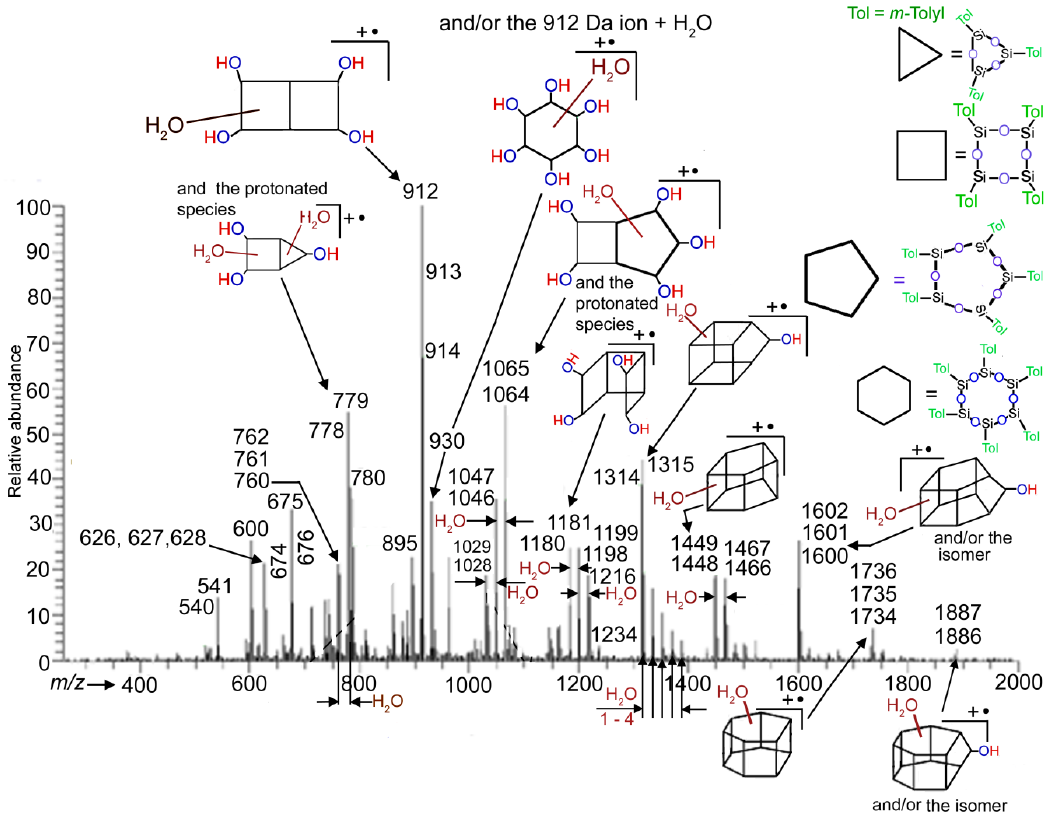
Figure 5. PI APCI mass spectrum of a mixture of m -tolylcyclosiloxane products from the hydrolysis- condensation reaction of 1 conducted at C HCl = 0.40 mol L − 1 for 24 h (see Note 6 in the SM).